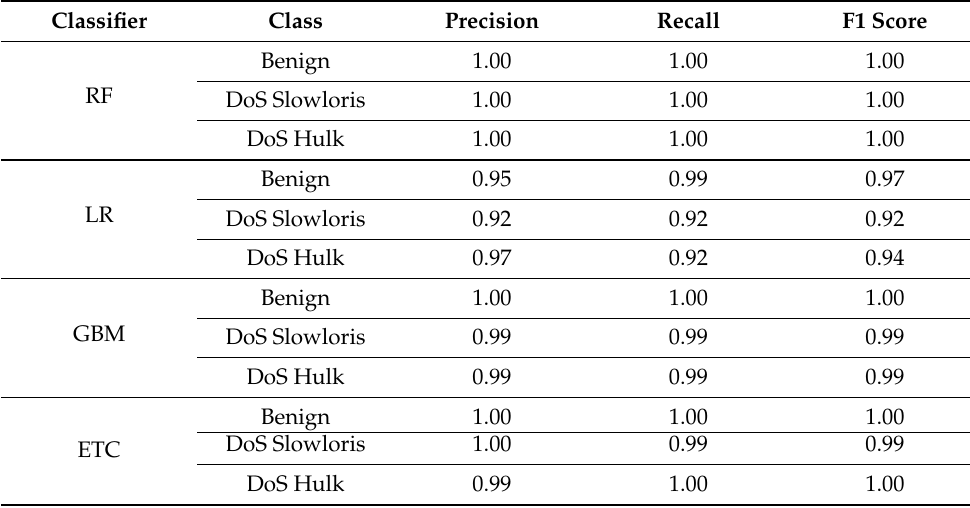
Table 7. Results of machine learning models for individual